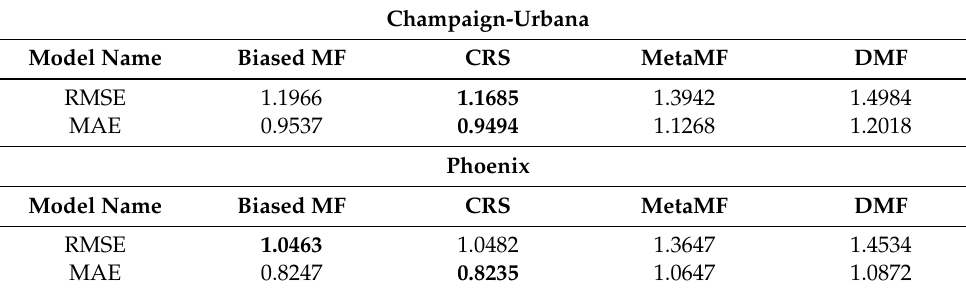
Table 3. Average Result Comparison (Champaign-Urbana).